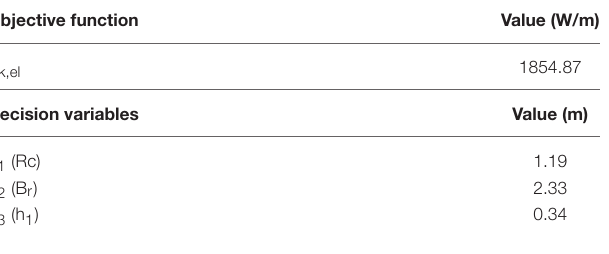
TABLE 2 | Optimal solution for OBREC device scenario 4. Objective